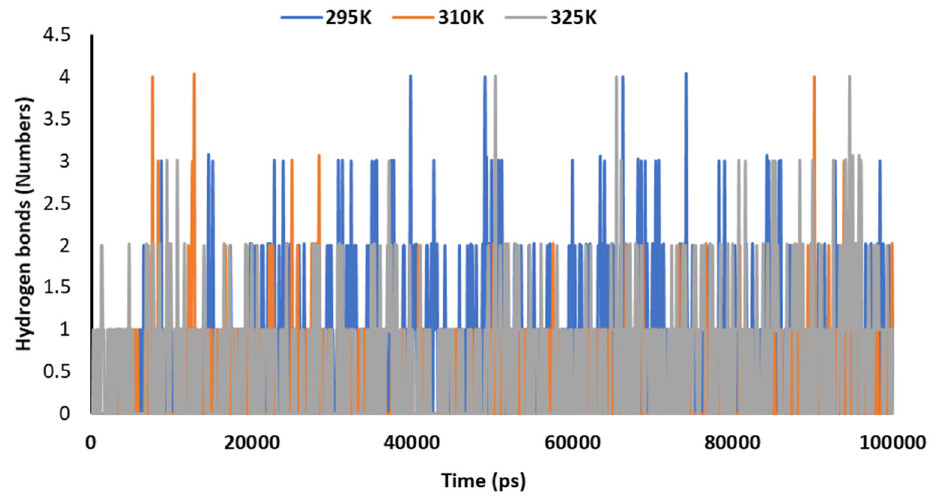
Figure 11. Trajectory of hydrogen bonds for the main protease of SARS-CoV-2 with 2DG at 295, 310 and 315 K.